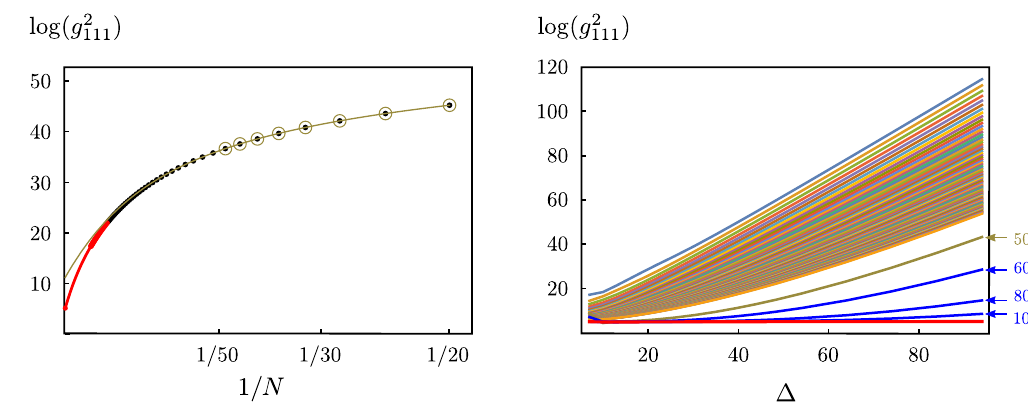
Figure 12 . Testing the extrapolations to in(cid:12)nite N . See the main text for explanations. only lack a stress tensor operator. Upon taking the AdS radius to in(cid:12)nity these observables should transform smoothly into the (cid:13)at-space S-matrix of the QFT. This paper o(cid:11)ers